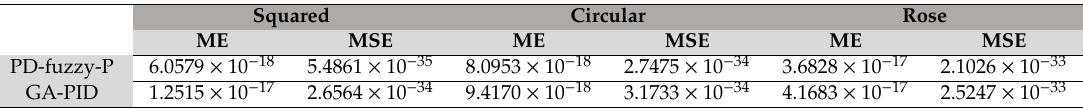
Table 5. The Mean Error and the Mean Square Error for both approaches in squared, circular, and rose